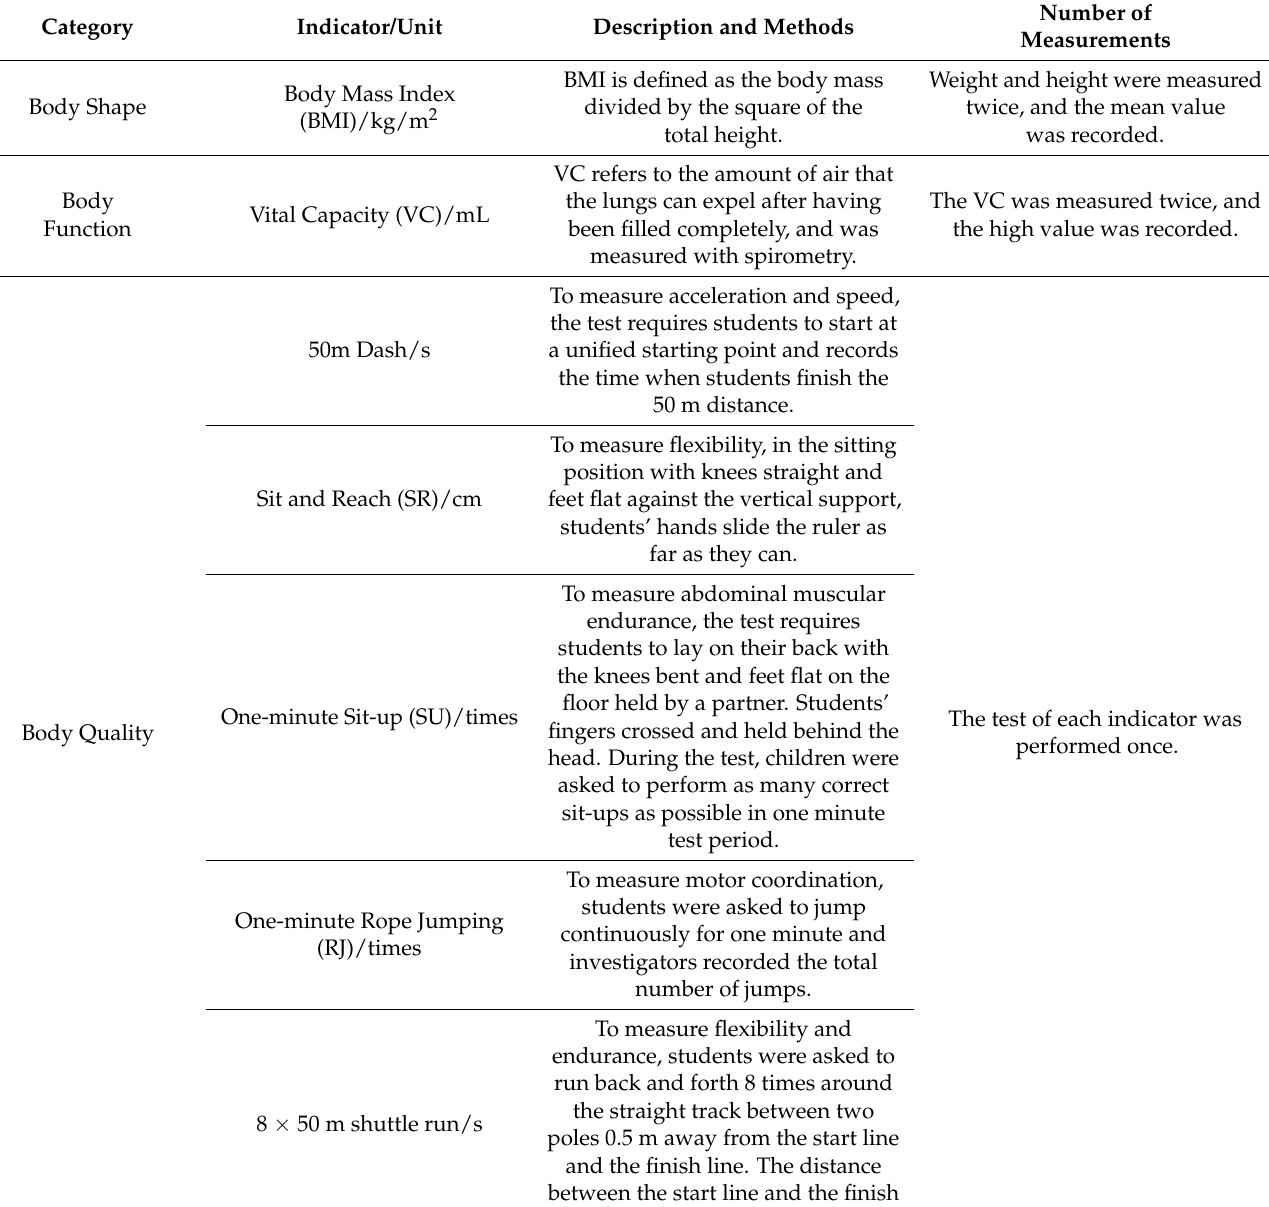
Table 1. The Measurement Indicators of